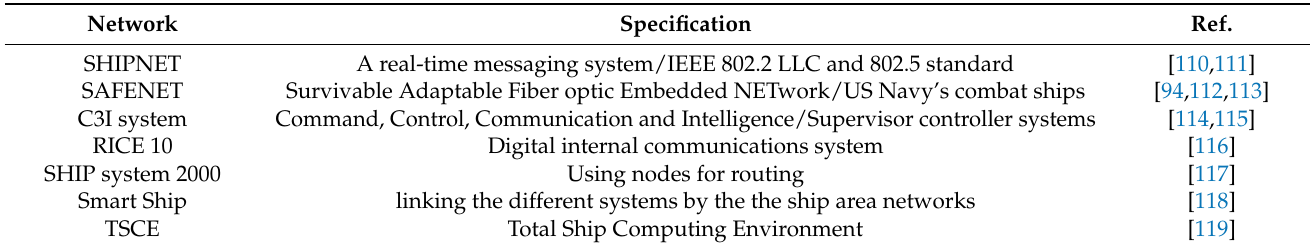
Table 4. Network